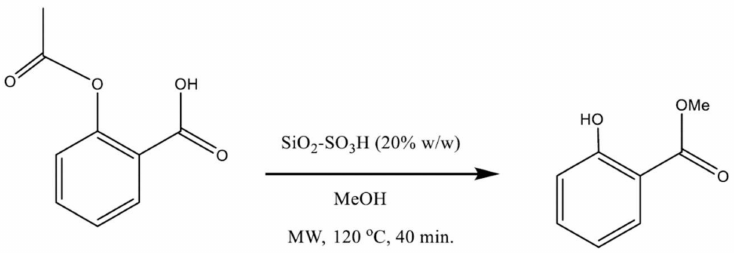
Figure 1. Reactions of the conversion of ASA into MS. The synthesis proceeds via the tandem transesterification–esterification reaction catalyzed by SiO 2 –SO 3 H.